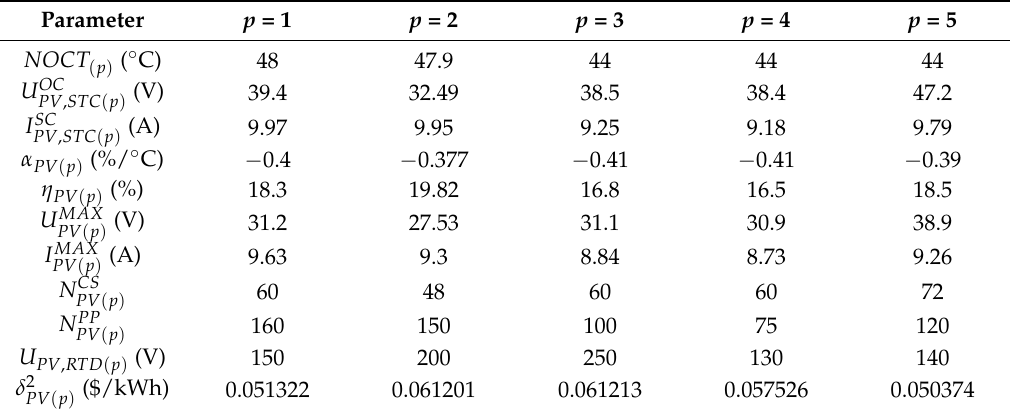
Table 4. Characteristics of distributed PV generator.